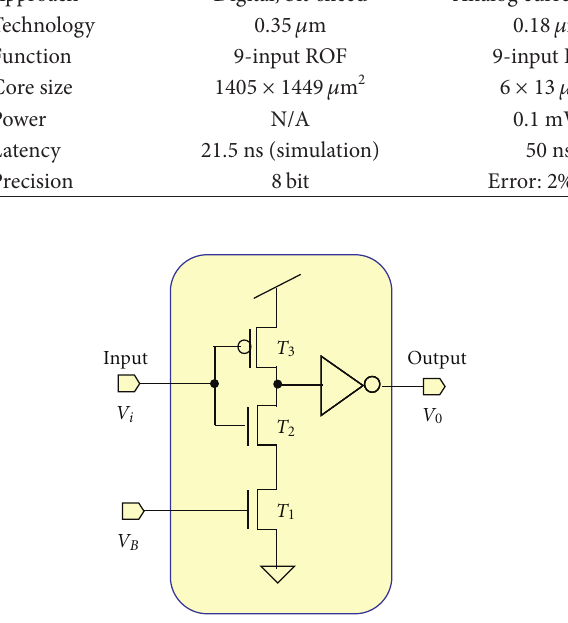
F 10: New proposed narrow-pulse